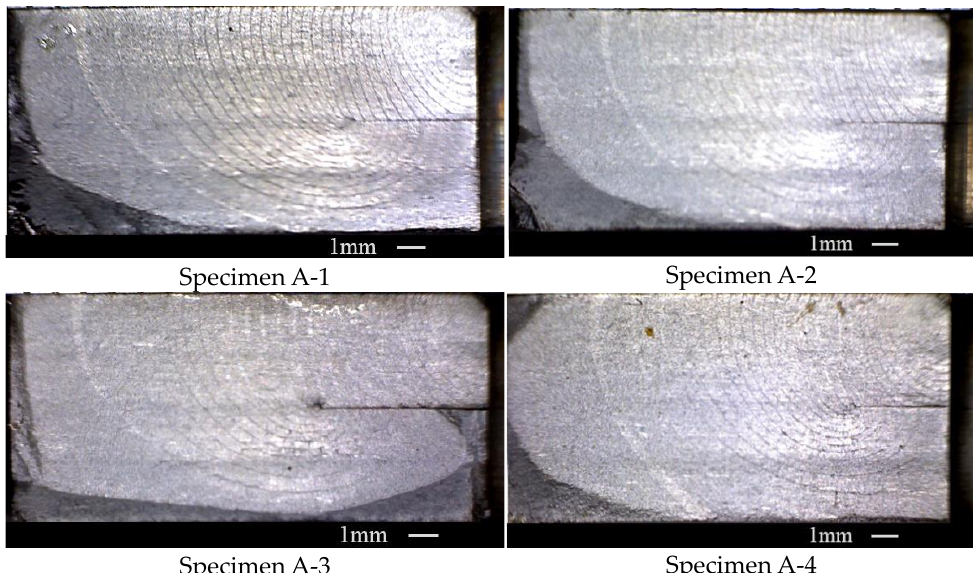
Figure 5. The four specimens’ fracture surface s of Group A.